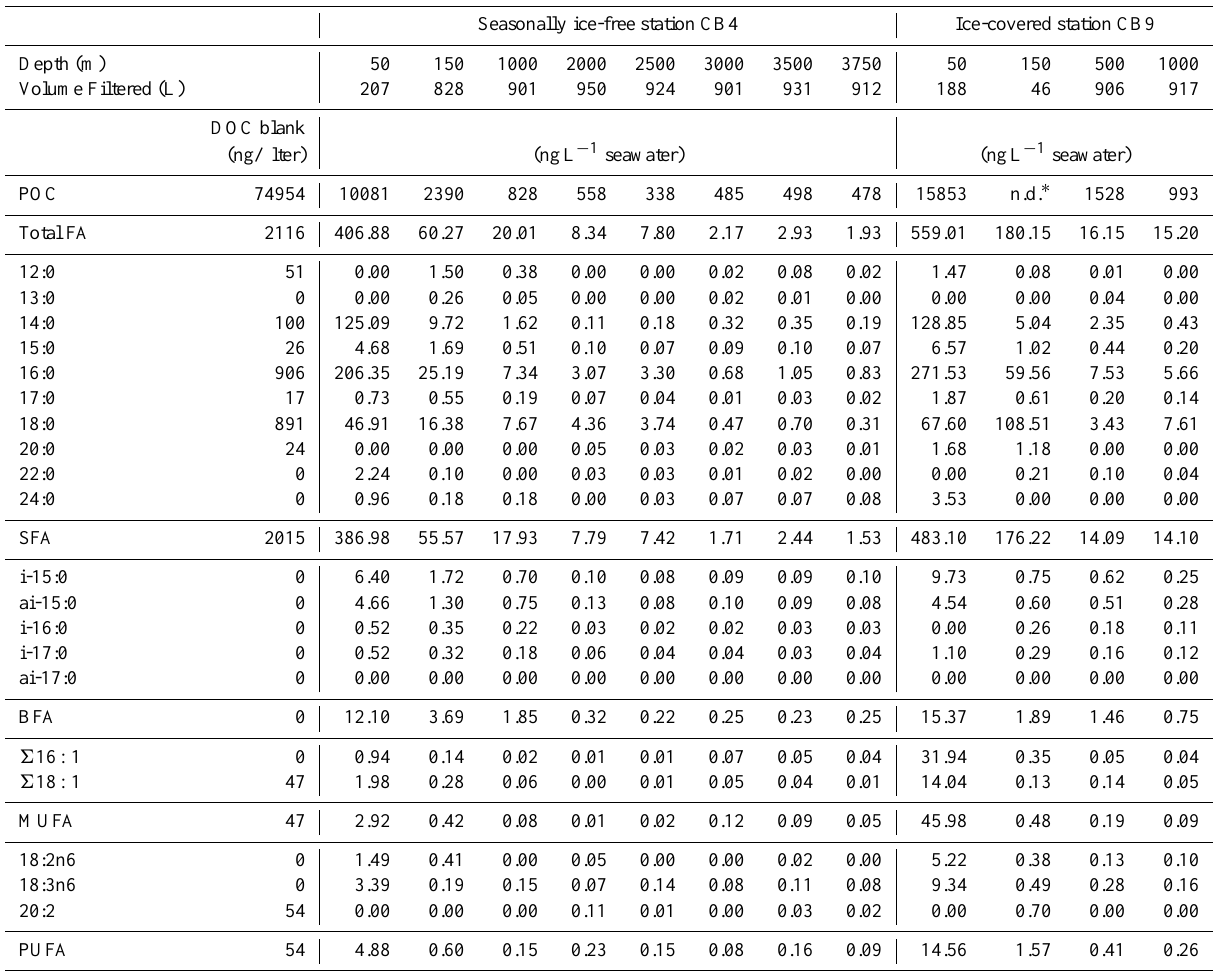
Table 1. Concentration of POC and FAMEs in the Canada Basin.